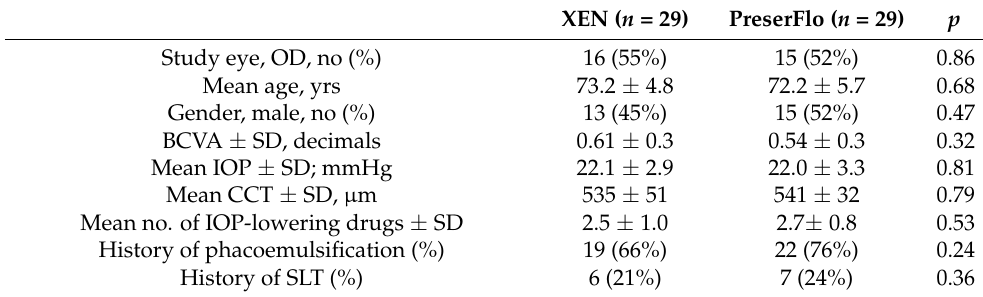
Table 2. Baseline demographic and clinical characteristics of the study